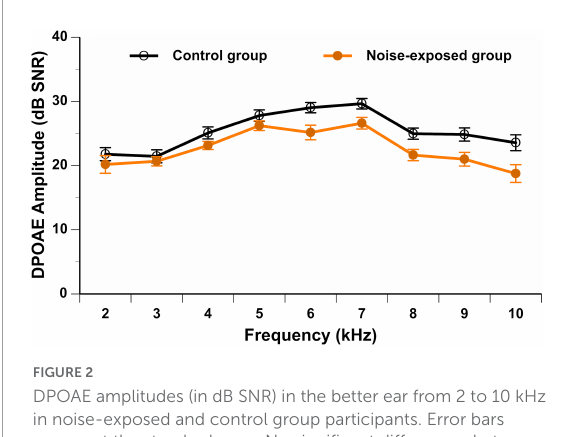
mean of CNE was 96.3 ± 5.6 units of noise exposure (dBA.year),